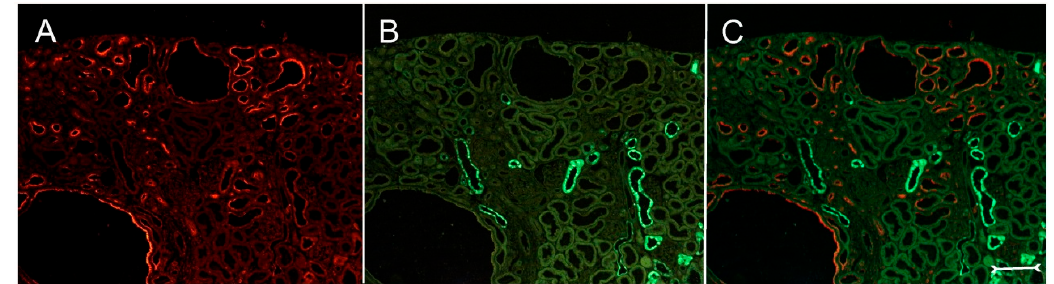
Figure 7. Double labeling experiments with anti-Kim-1(( A ), red) and anti-calbindin-D28k (( B ), green); merged view in ( C ); in an overview of a (cy/+) kidney cortex. Calbindin-D28k is expressed in distal nephron segments and is not observed in Kim-1-positive profiles or cysts with apically-accented staining. Bar = 150 µm.